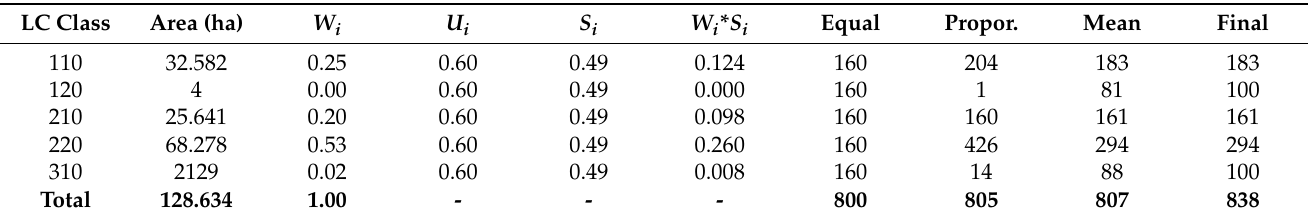
Table A2. Calculation of the sample size of the land cover map of the municipality of Rome from multi-temporal data classification.